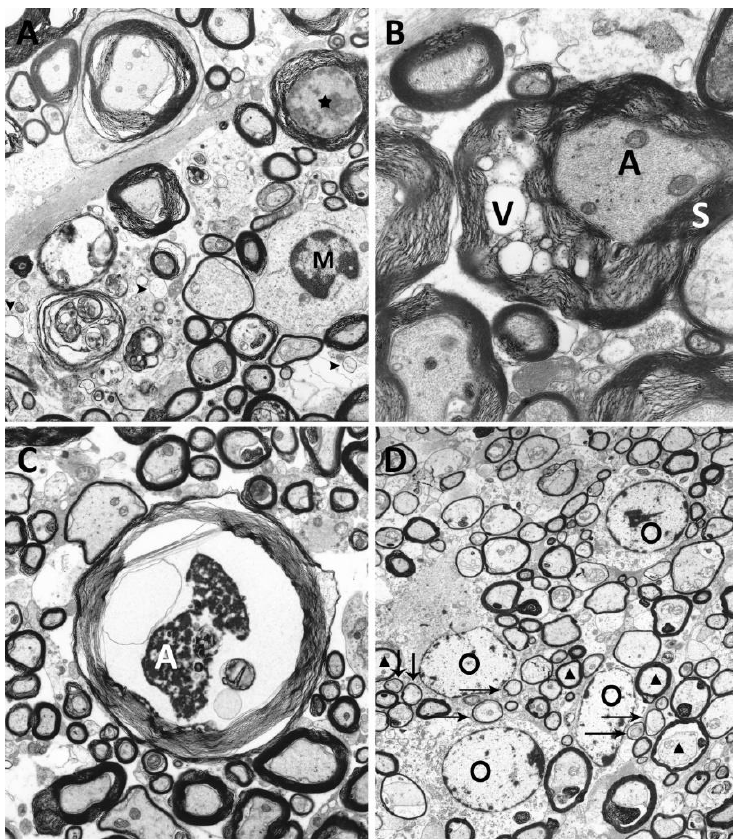
Figure 5. Ultrastructural analysis of degenerative changes of axons and myelin sheaths of TMEV infected SJL-mice. ( A ) Demyelinated area with denuded axons [arrowheads] and infiltration of microglia/macrophages [M] and axonal degeneration [asterisk] within the ventrolateral areas of the spinal cord (TMEV infected animal, 42 dpi, magnification 5000 × ). ( B ) Vacuolation [V] of myelin sheath [S] surrounding an intact axon [A] (TMEV infected animal, 98 dpi, magnification 10,000 × ). ( C ) Axonal [A] degeneration characterized by shrinkage, an uneven axonal membrane and accumulation of electron dense material (TMEV infected animal, 98 dpi, magnification 5000 × ). ( D ) Multiple remyelinated axons [arrows], characterized by thinner myelin sheaths compared to normally myelinated fibers [triangles], characteristic for oligodendrocyte [O] mediated remyelination were detected (TMEV infected animal, 196 dpi, magnification 6300 ×